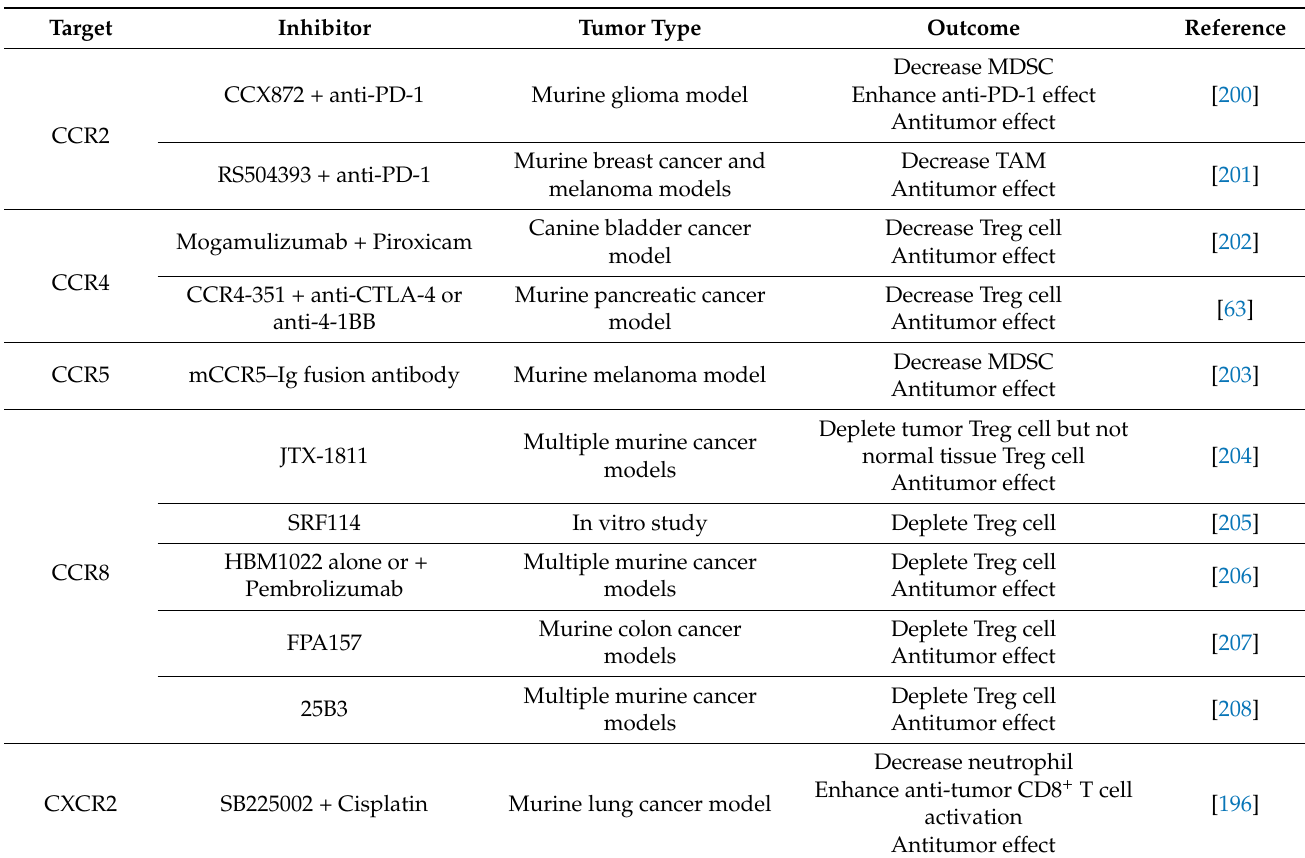
Table 2. Therapeutic effects of chemokine receptor inhibitors in preclinical studies.